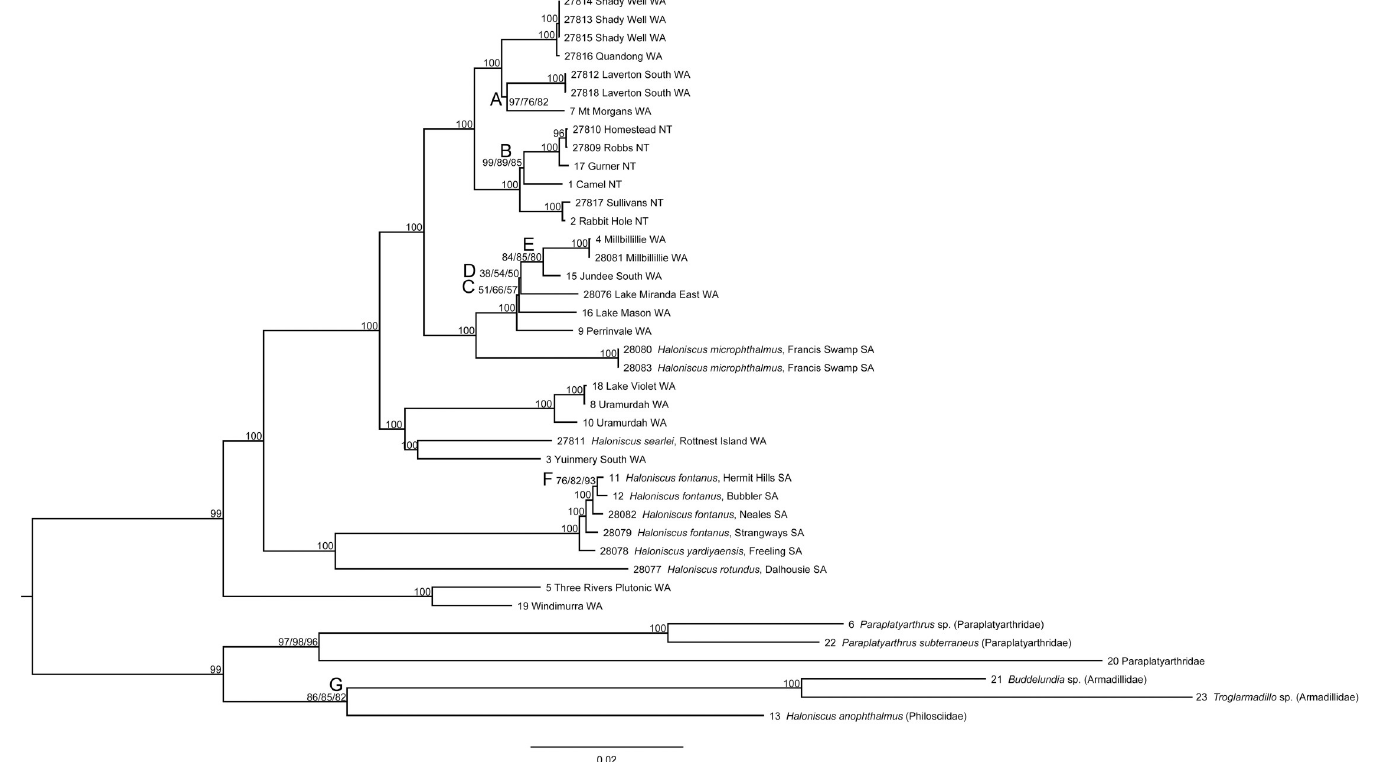
Fig 5. Maximum likelihood (ML) phylogeny of Haloniscus and outgroup isopod taxa inferred using RAxML. The phylogeny represents trees reconstructed using three datasets (datasets A–C) for which the resultant topologies were identical (see S10 Fig for all trees). ML bootstrap values are summarised on branches (i.e. datasets A, B and C, respectively, with each value separated by a forward slash unless all values are identical). Letters A–G represent branches with support values that differ significantly across the phylogenies and/or are referred to in the text. Isopod taxa are listed by species name and/or collection locality. Included abbreviations are as follows: WA = Western Australia, SA = South Australia, and NT = Northern